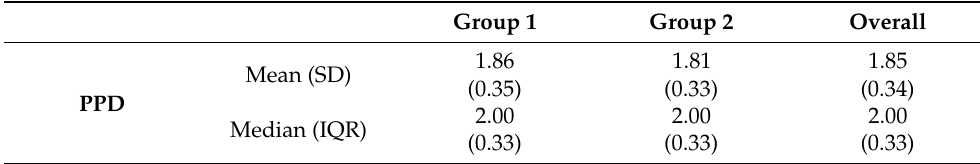
Table 5. Probing pocket depth in Group 1 (EA ≥ 30 ◦ ) and Group 2 (EA < 30 ◦ ).